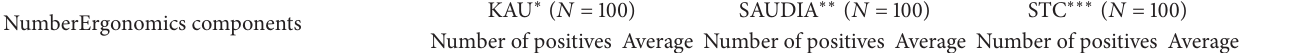
Table 3: Positive ergonomics components of the examined workstations. NumberErgonomics